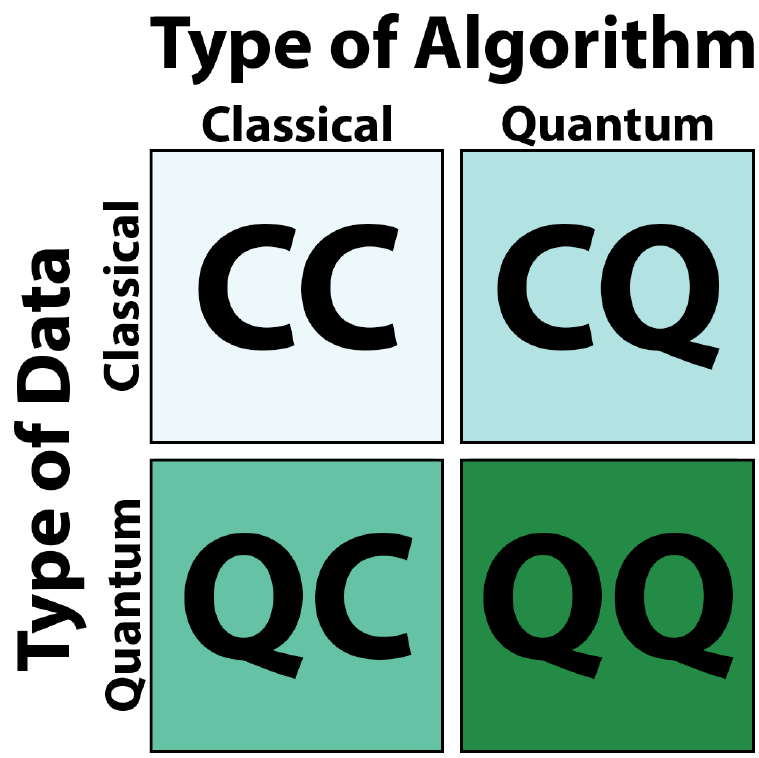
Figure 3. Depending on the type of data and the algorithms used, there are four possible approaches to combine the Machine Learning and Quantum Computing